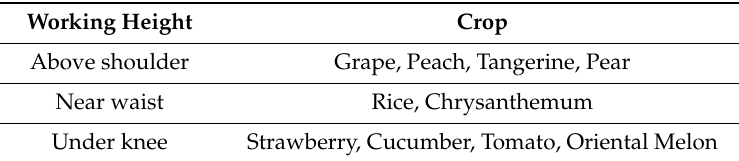
Table 1. 10 selected crops based on the working height.